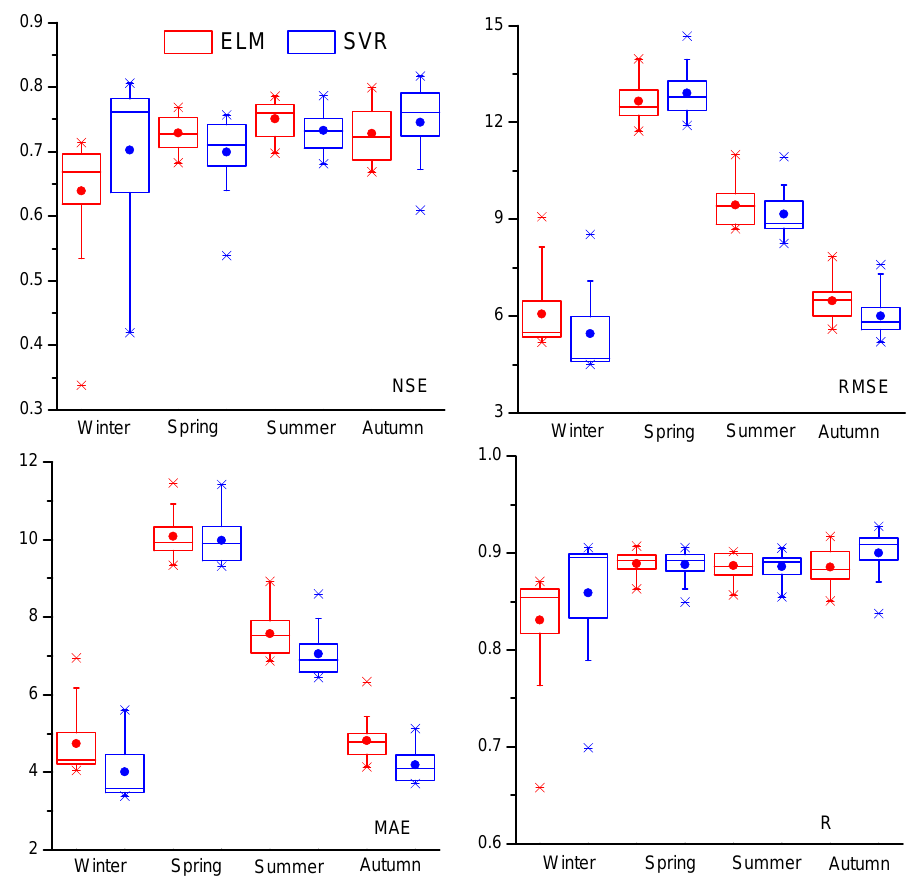
Figure 6. Performances of the ELM and SVR model for downscaling GCM-derived ET 0 at seasonal scales during the 1961–2005 period.